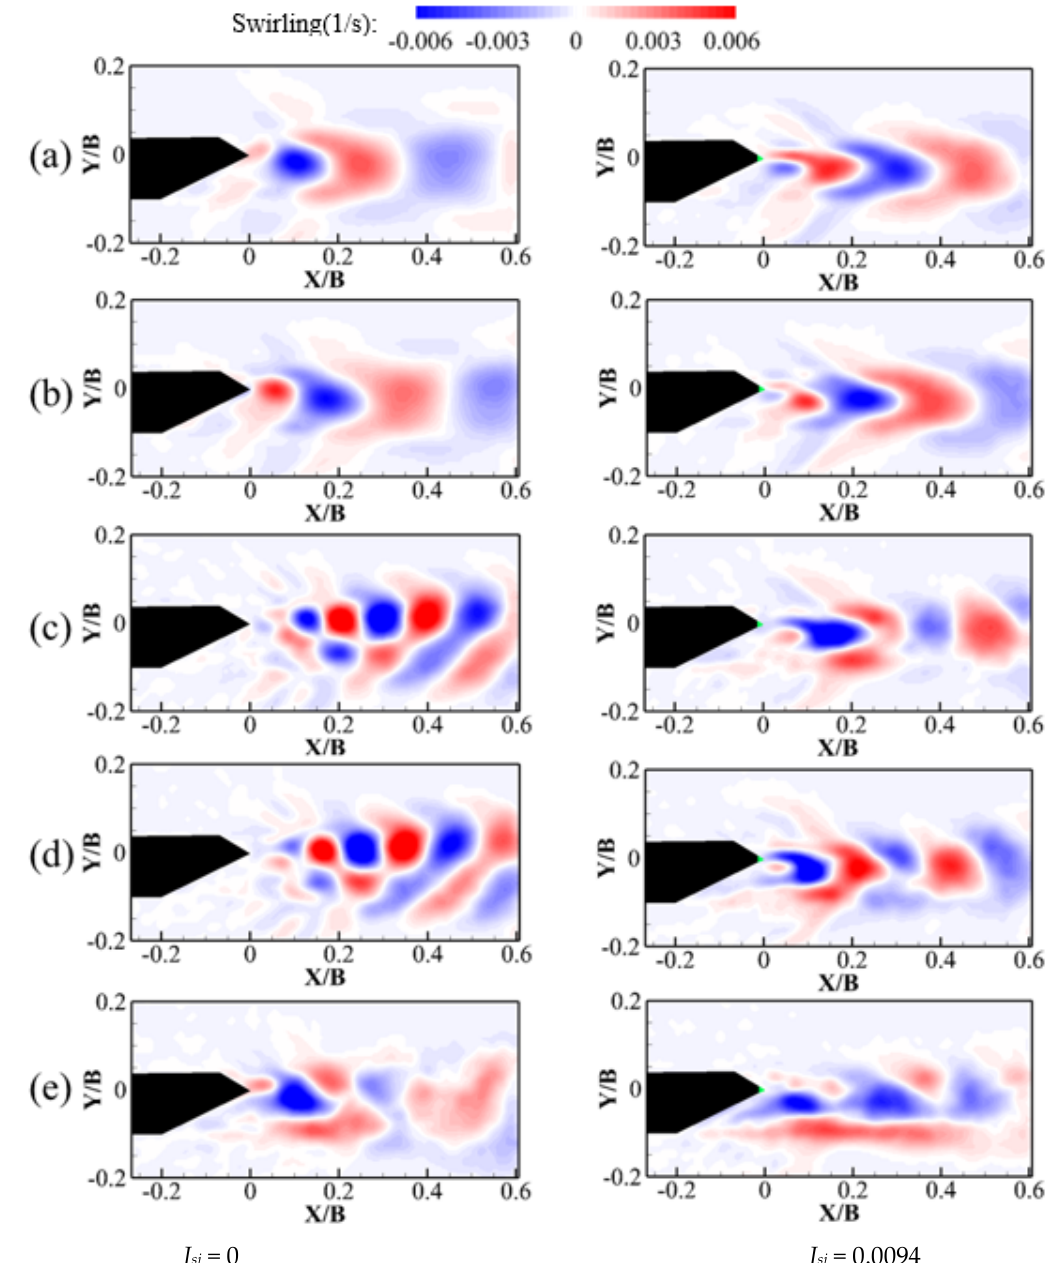
Figure 10. The POD mode of the wake flow in measurement plane I. ( a ) mode 1, ( b ) mode 2, ( c ) mode 3, ( d ) mode 4, and ( e ) mode 5.